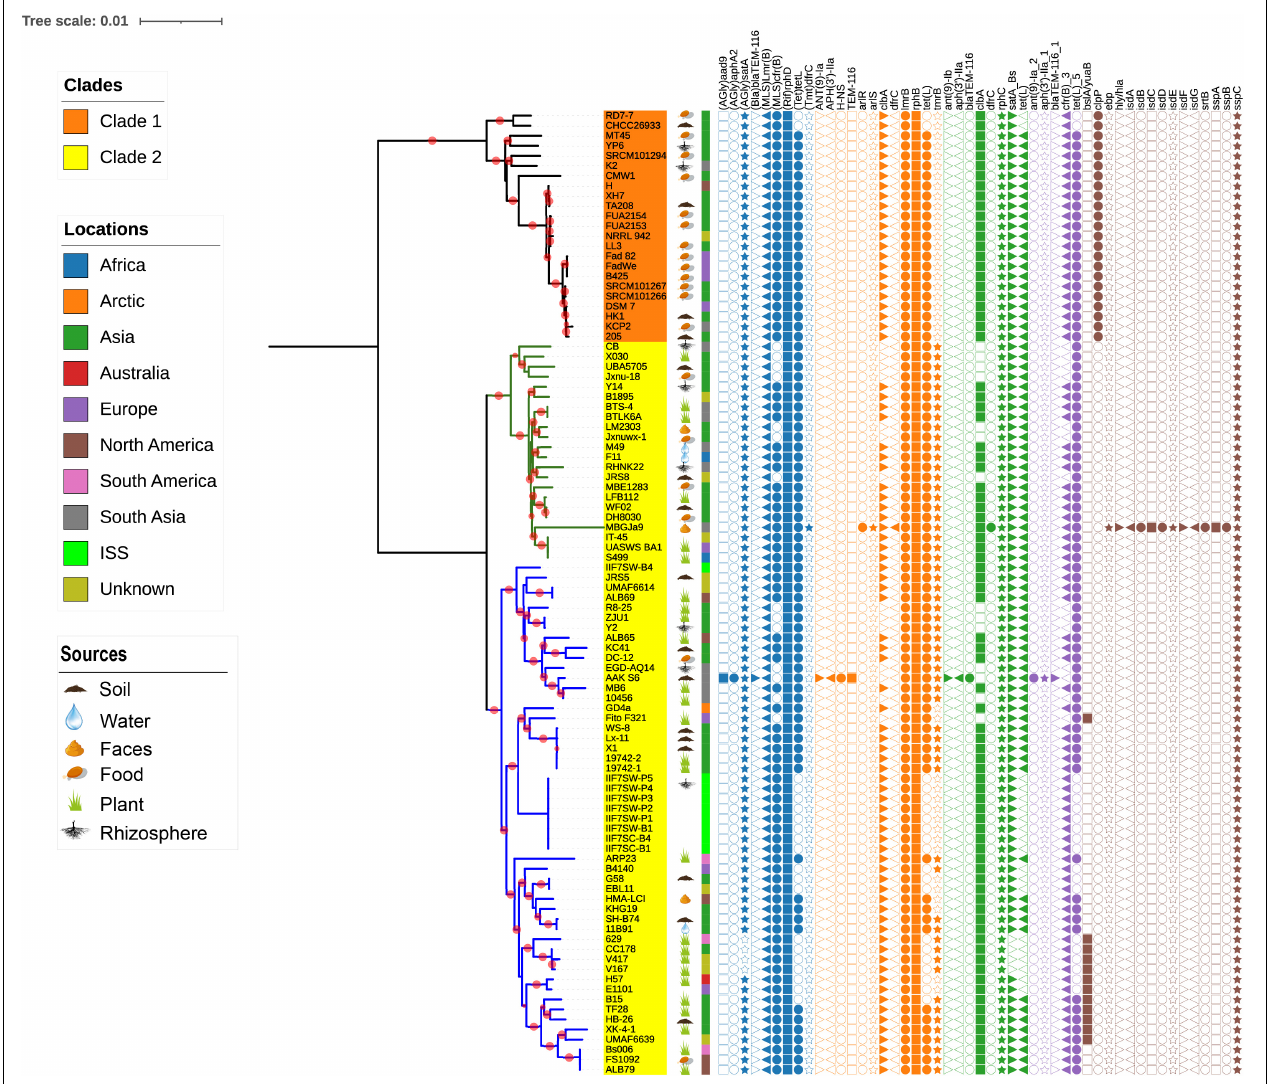
FIGURE 5 | The midpoint rooted phylogenetic tree of single-copy core proteins. The tree was constructed by the module “CoreTree” of PGCGAP v1.0.21 (Liu et al., 2020) with the best fit model JTT+F+R4. Red circles on the branch represent bootstrap values larger than 80%. The background color of the labels represents the clades, and the green and blue branches represent cluster 1 and cluster 2 of clade 2, respectively. The cartoons after the strain name indicate that the strain was isolated from soil, food, rhizosphere, water, or faces of herbivores, or is associated with the plant. The color strip outside the tree describes where the strain was isolated; ISS means International Space Station. The symbols on the right side of the tree represent antibiotic resistance genes or virulence genes from each database [blue: argannot (Gupta et al., 2014), orange: card (Jia et al., 2017), green: NCBI (Michael Feldgarden et al., 2019), purple: resfinder (Zankari et al., 2012), and gray: vfdb (Chen et al.,